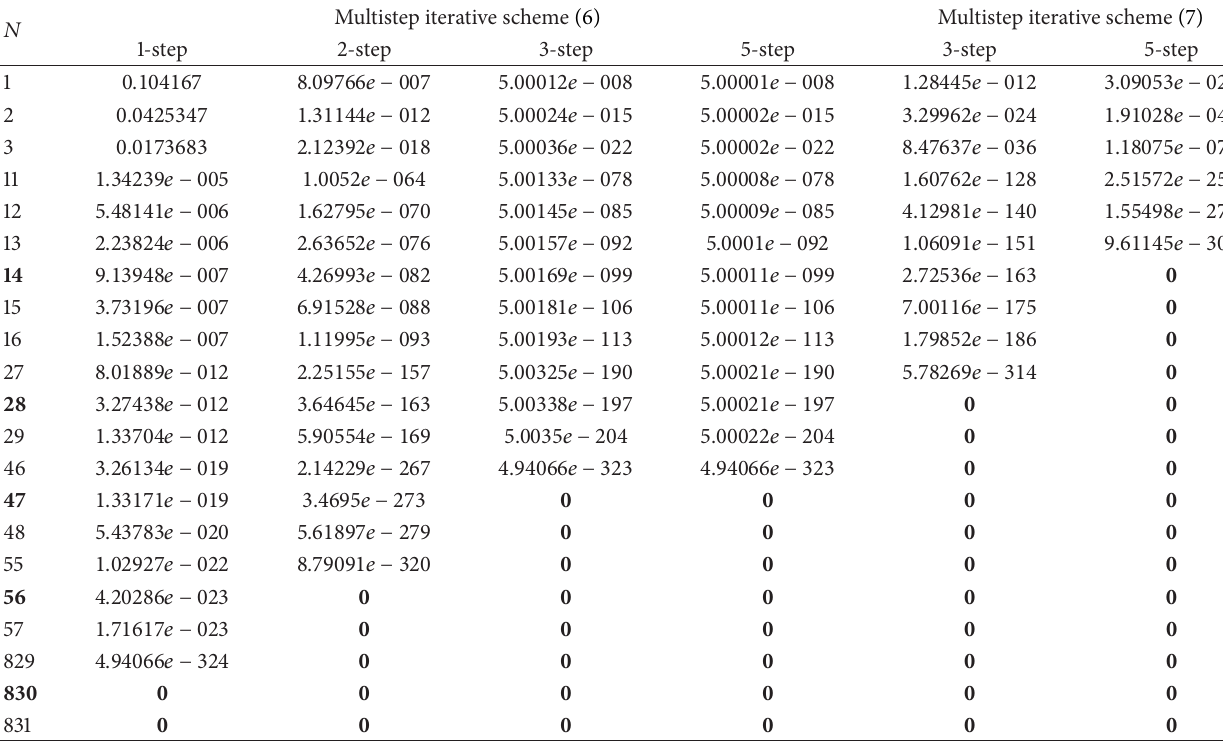
Table 1: Showing the convergence of different iterative sequences to common fixed point { 0 } of countable family of multivalued quasi nonexpansive mappings. From the table we can compare the converging step of one-step, two-step, multistep (6), and multistep (7) iterative schemes and conclude that multistep iterative scheme (7) converges faster than one-step, two-step, and multistep iterative schemes